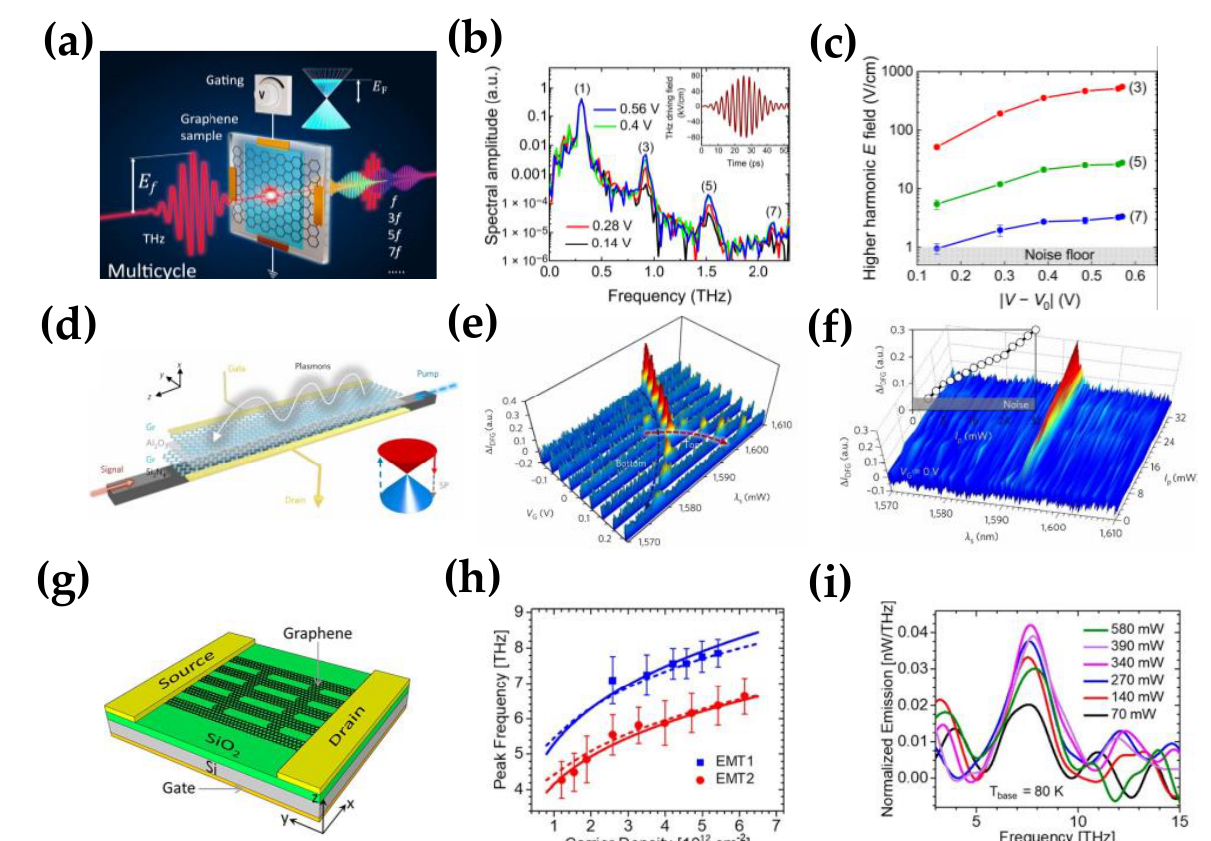
Figure 8. THz generation. ( a ) Gated graphene sample device for tuning the high harmonic generation. ( b ) Amplitude spectra of terahertz wave and high harmonics transmitted through the gra- phene. ( c ) Tunability of HHG efficiency as a function of gating voltage, Inset: the driving terahertz signal; (Reprinted with permission from ref. [26] Copyright 2021, American Association for the Ad- cone structure of the DFG process. ( e ) Tuning of the graphene terahertz plasmon signal. ( f ) DFG